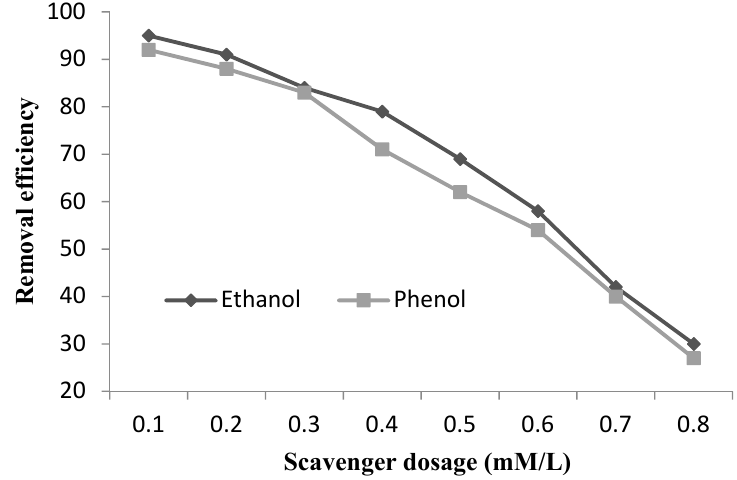
Figure 9. Influence of two radical scavengers on removal efficiency of RR198 under optimum conditions.